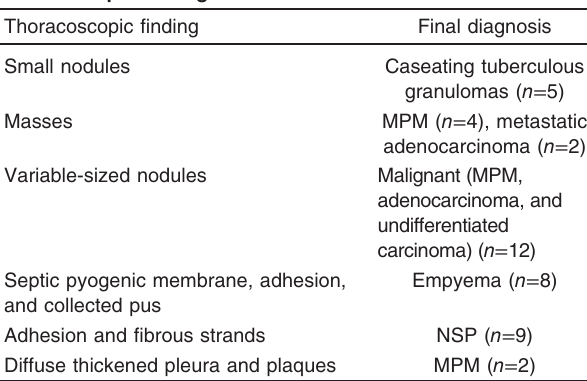
Table 4 Distribution of studied patients in relation to thoracoscopic findings